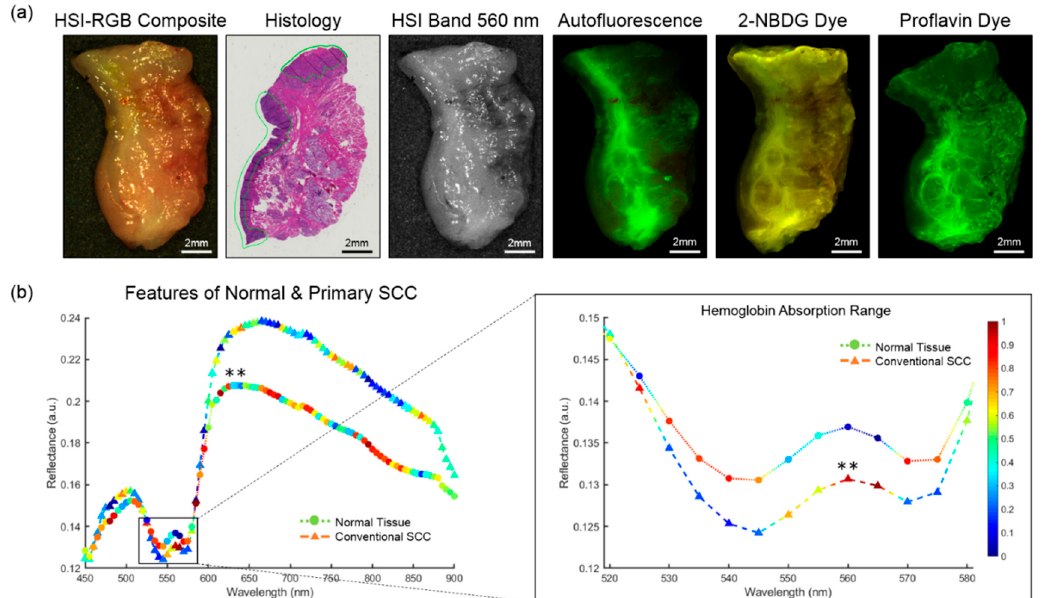
Figure 1. A representative cancer-involved tissue specimen of conventional, keratinizing SCC of the mandibular gingiva. ( a ) From left to right: RGB image made from HSI. The histological image, which serves as the ground truth, has SCC annotated in green. HSI single band at 550 nm. Fluorescence imaging modalities of the same specimen; ( b ) Spectral feature saliency from CNN gradients of correctly classified HSI for conventional SCC and normal upper aerodigestive tract tissues. Left: Full spectra from 450 to 900 nm of SCC and normal tissues. Symbol colors represents the relative, scaled importance of the spectral feature for making the correct prediction of cancer or normal from the HSI (0 is low saliency; 1 is high saliency). Right: Spectral cutout from 520 to 580 nm, corresponding to the hemoglobin range. The double asterisk (**) indicates that statistically significant differences ( p < 0.01) were observed in reflectance values between SCC and normal for all spectral bands (450 to 900 nm). The most important spectral feature for correctly predicting SCC in HSI was the oxygenated hemoglobin peak at 560 and 565